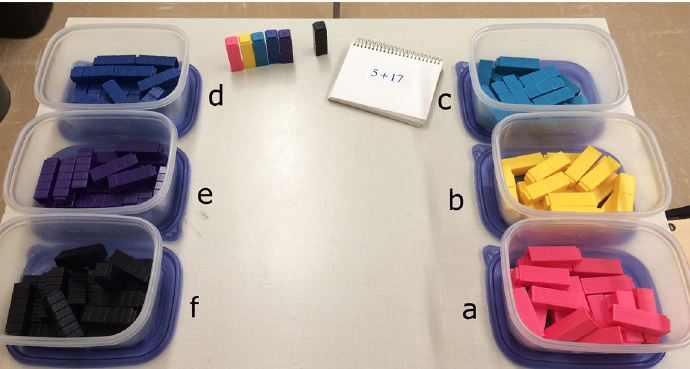
Figure 1. To model the expressions, children were provided with unlabeled fraction bars. The pink bars (a) could not be further divided. The yellow bars (b) could be divided into halves. The light blue bars (c) could be divided into thirds. The dark blue bars (d) could be divided into fourths. The purple bars (e) could be divided into fifths. The black bars (f) could be divided into